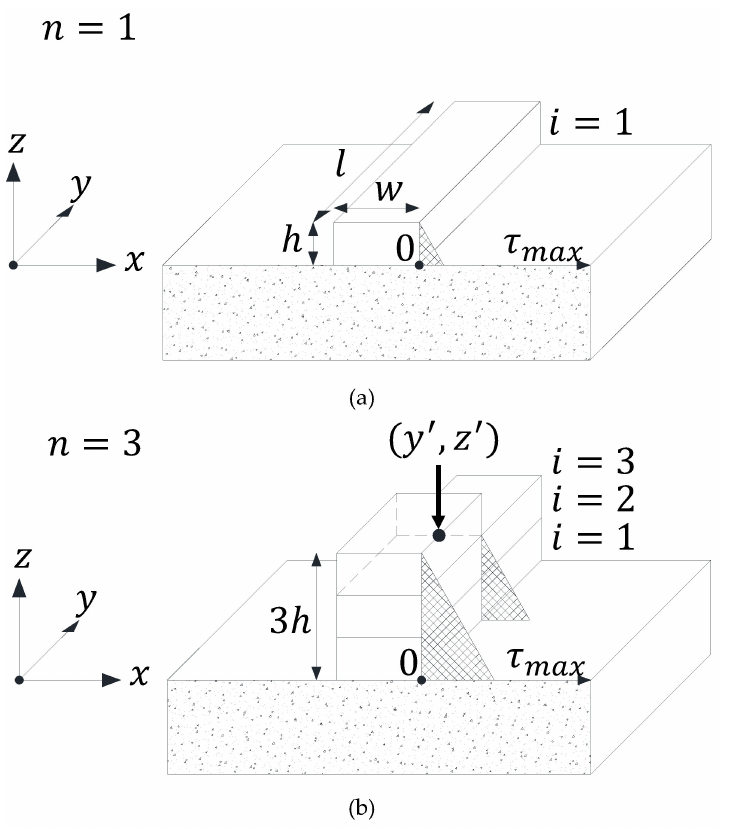
Figure 4. Maximum shear stress distribution of built up fresh concrete. ( a ) Case of n = 1 & fully built up layer; ( b ) Case of n = 3 & half laminated